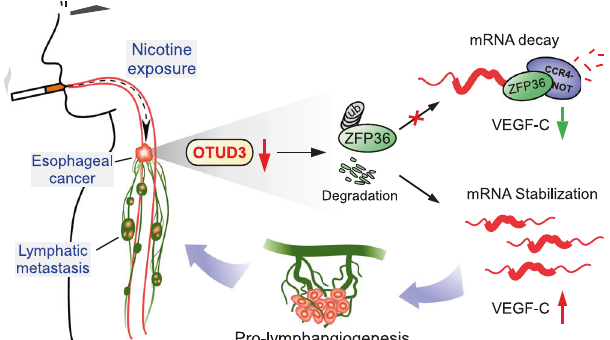
Fig. 8 Study model. Nicotine-mediated OTUD3 downregulation facilitates ZFP36 protein degradation and inhibits VEGF-C mRNA decay, leading to robust VEGF-C production, tumor-induced lymphangiogenesis,